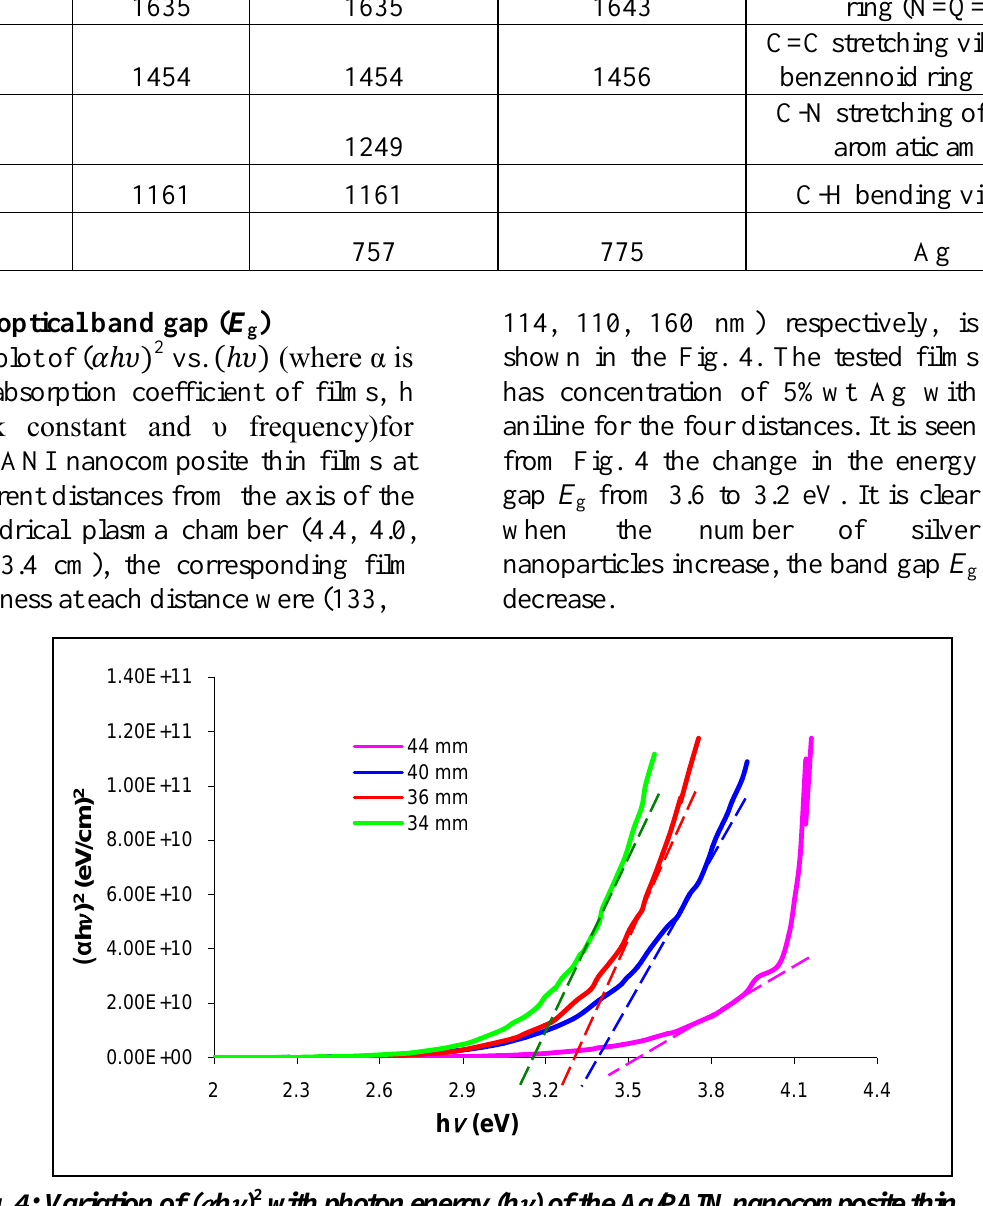
h ) 2 with photon energy (h films at difference 𝛼𝛼 𝜈𝜈